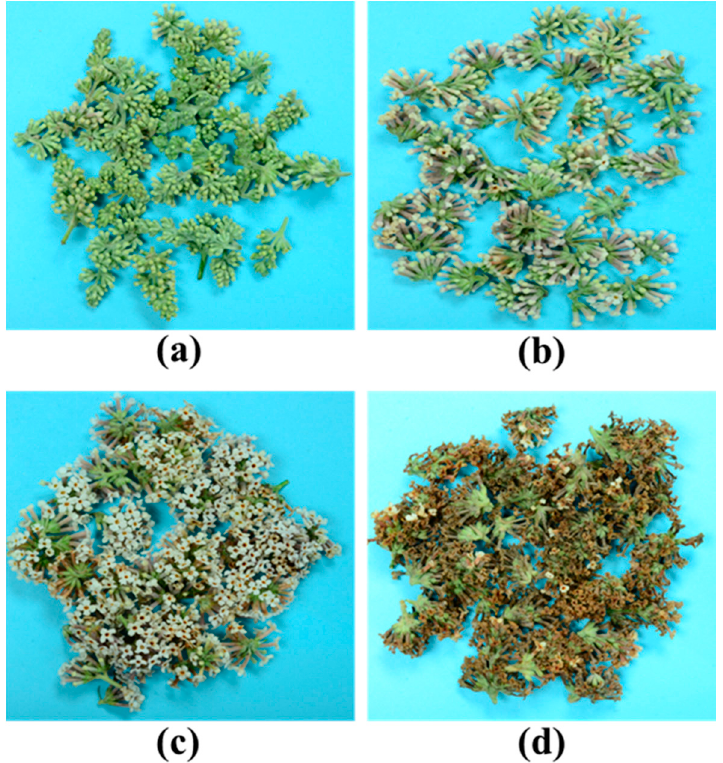
Figure 5. Fresh materials of B. officinalis at four different growth periods: ( a ) bud; ( b ) early flower; ( c ) full-blossom; ( d ) withering stage.